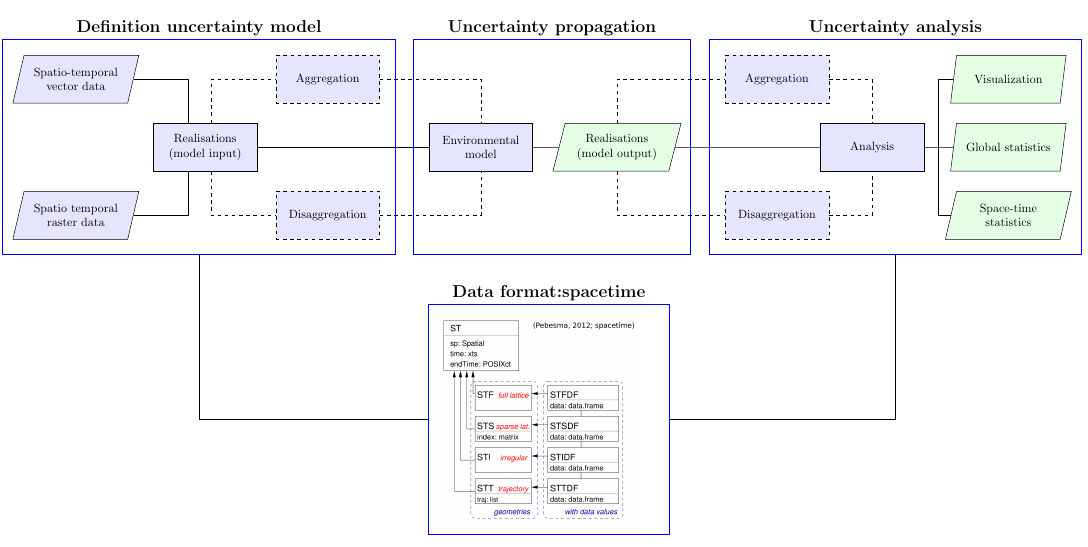
Figure 1. Conceptual framework for uncertainty propagation across multiple scales with the stUPscales package. Blue rectangular node = process; blue trapezoidal node = input; green trapezoidal node = output; solid line = path; dashed line = optional